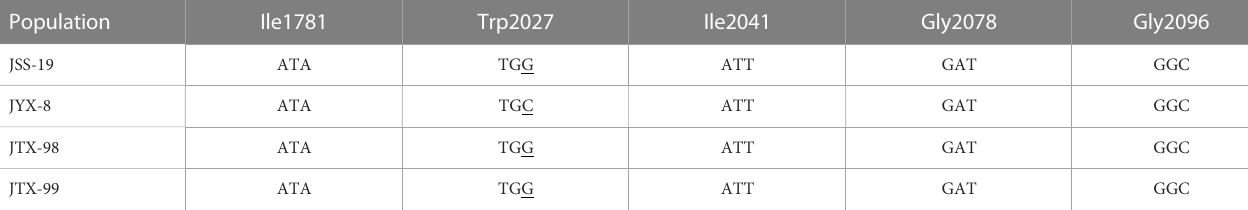
TABLE 5 The mutation sites of ACCase gene in different D . ciliaris var. chrysoblephara populations. Population